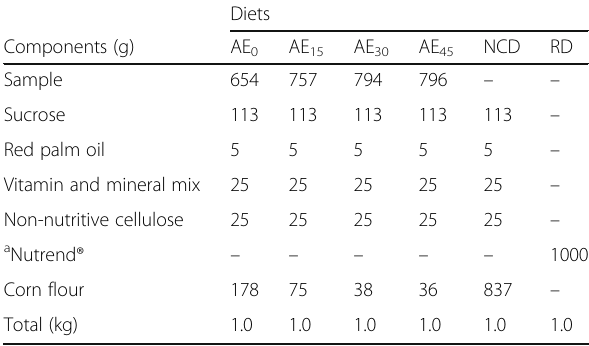
Table 1 Composition of formulated diets